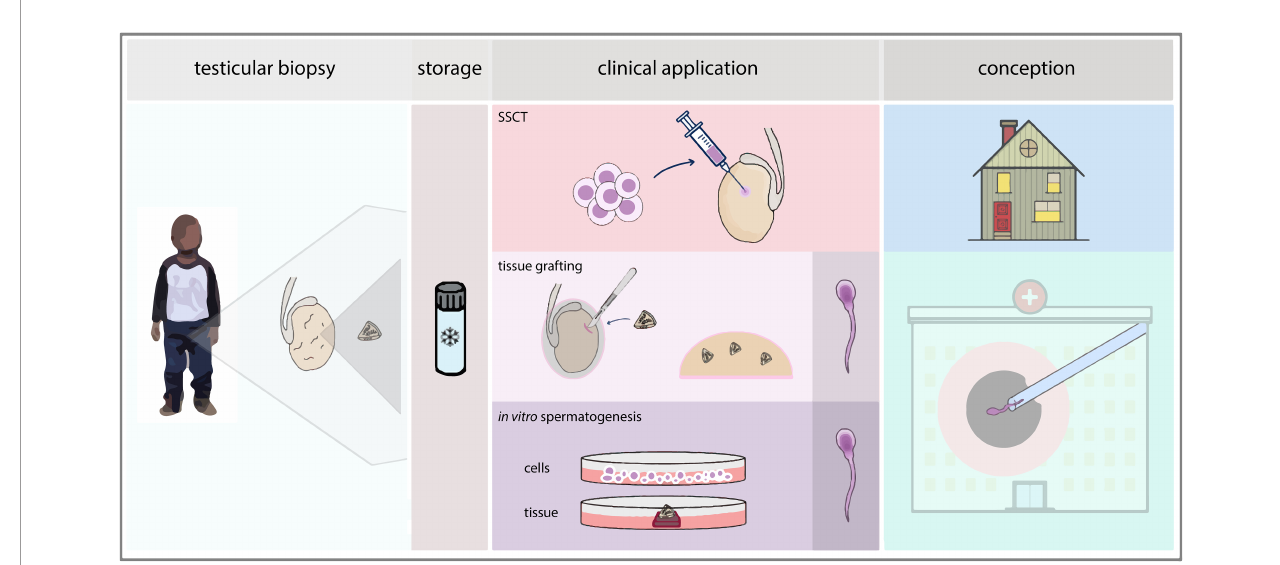
FIGURE 1 | Pathways in fertility restoration. After cryopreservation of a testicular biopsy, clinical application of SSC-based techniques can be sought via SSCT, testicular tissue grafting or in vitro spermatogenesis, either through cell-based or tissue-based culture. For SSCT, natural conception could be achieved whereas for therapies based on grafting or in vitro spermatogenesis, an ICSI procedure would be performed using elongated spermatids derived from the